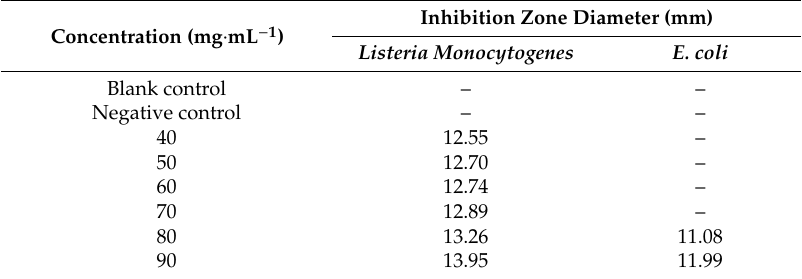
Table 2. Antibacterial e ff ect of microcapsules on Listeria monocytogenes and E. coli